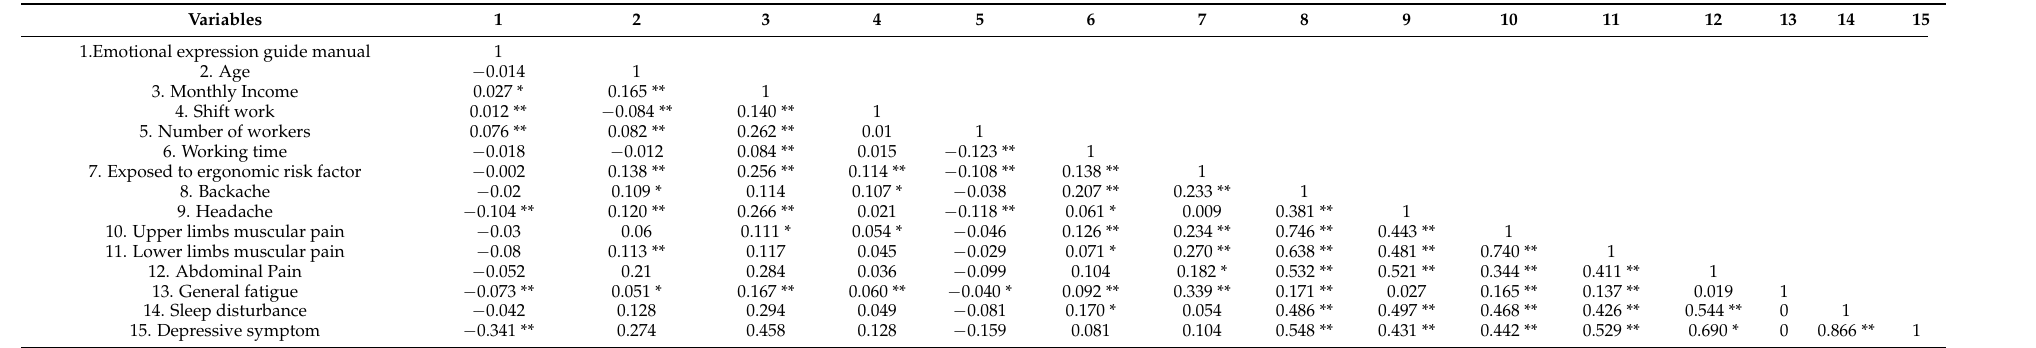
Table 3. Correlations among variables used in this